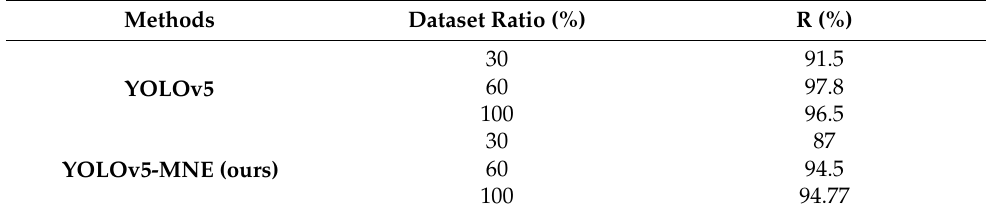
Table 14. Comparison of experimental results for different SSDD data